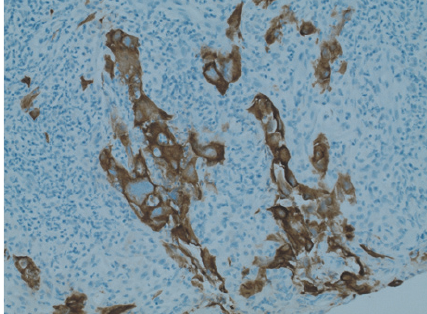
Figure 4: Intermediate power view of the tumour showing a cellular proliferation of pleomorphic cells with epithelioid morphology (H&E stain, 200x original magnification).